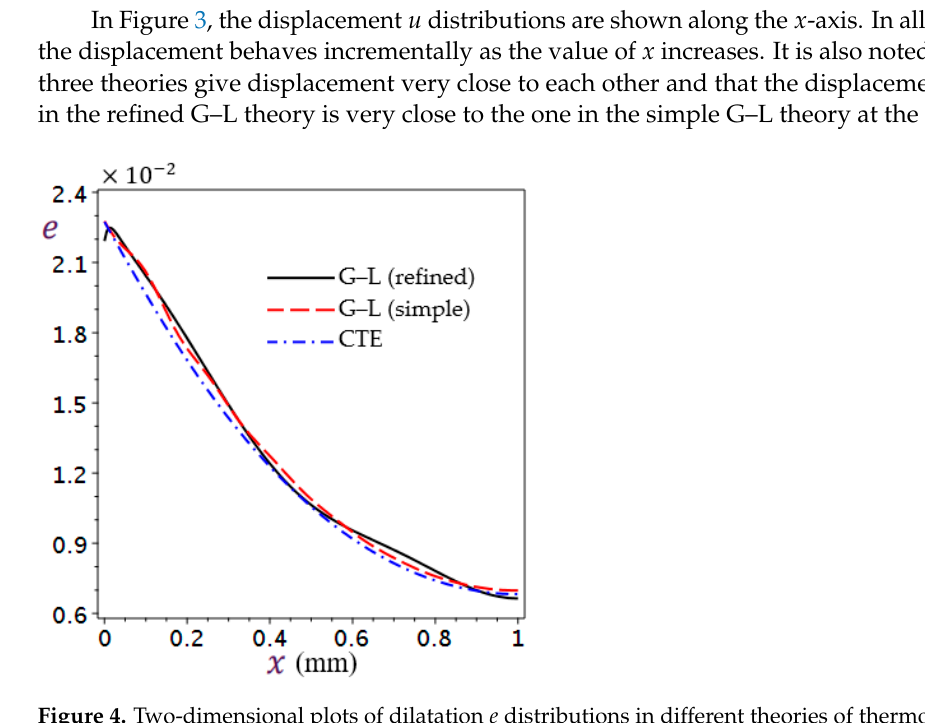
Figure 5. Two-dimensional plots of normal stress 𝜎 distributions in different theories of thermoe- lasticity.